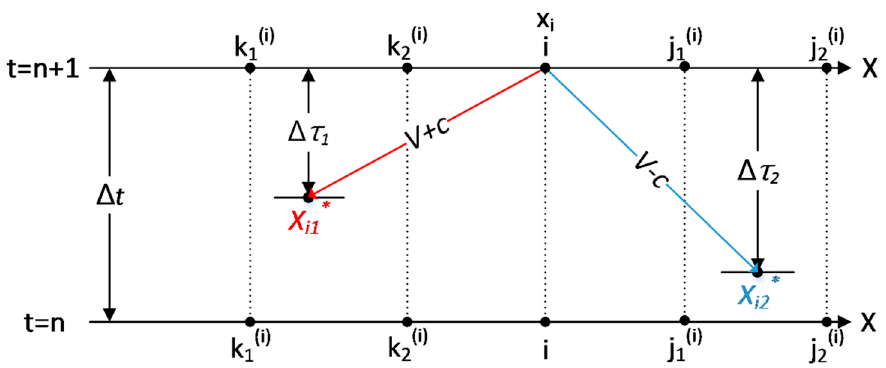
Figure 2. Illustration of the respective characteristics’ lines in one-dimensional backward